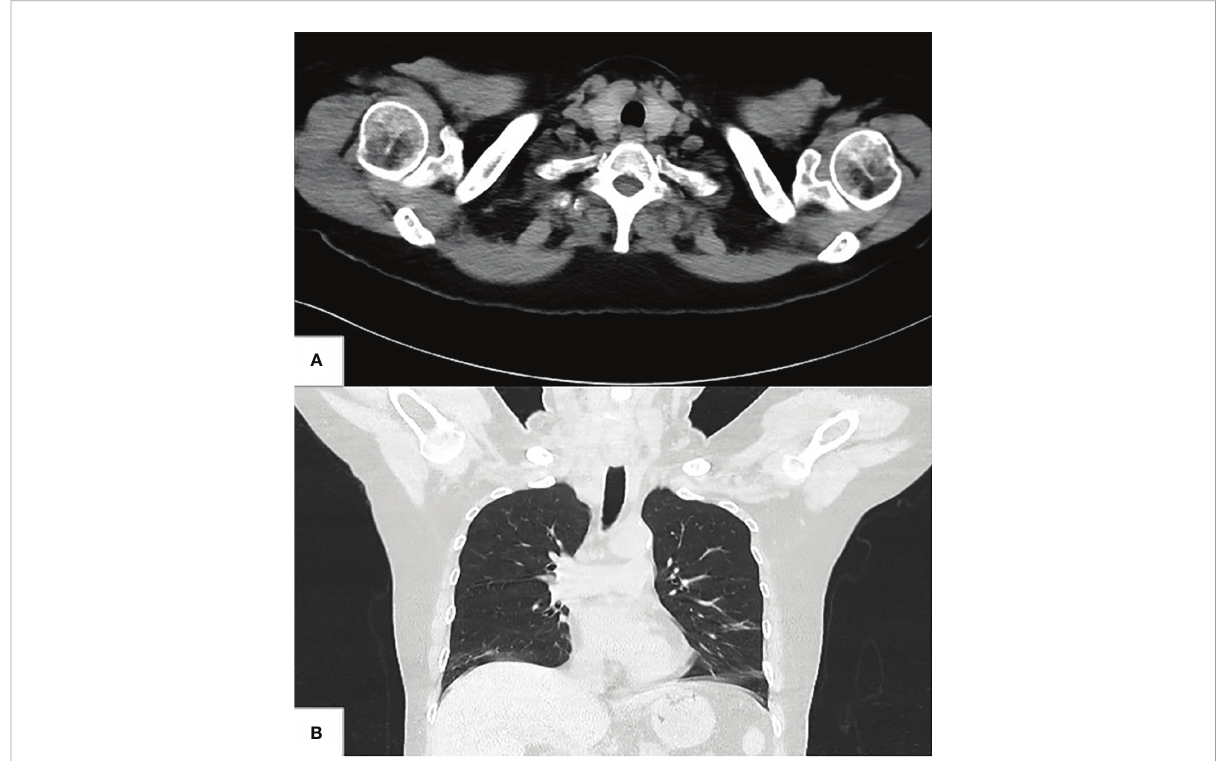
FIGURE 3 Postoperative neck – chest CT. (A) Transverse image shows the right anterior wall of the cervical trachea returned to normal. (B) coronal image shows the right anterior wall of the cervical trachea returned to